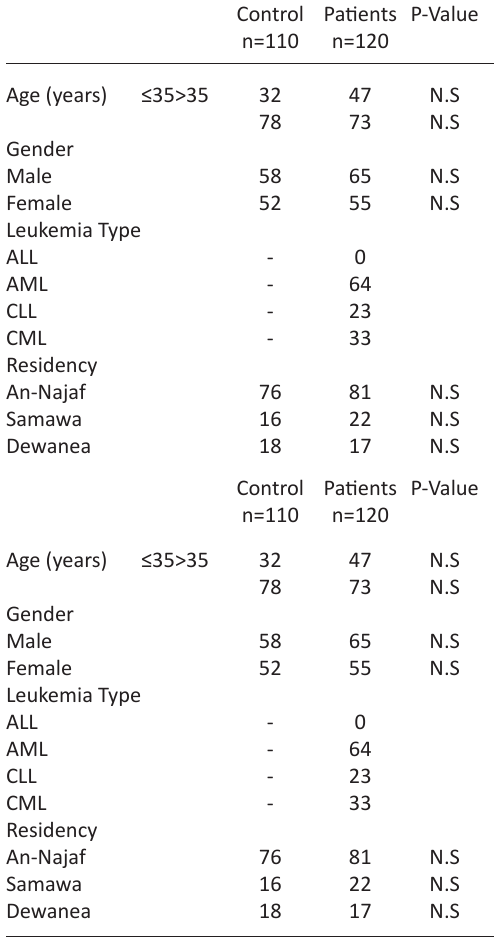
Table 1. Distribution of known clinicopathological variables of leukemia patients and control groups Control Patients